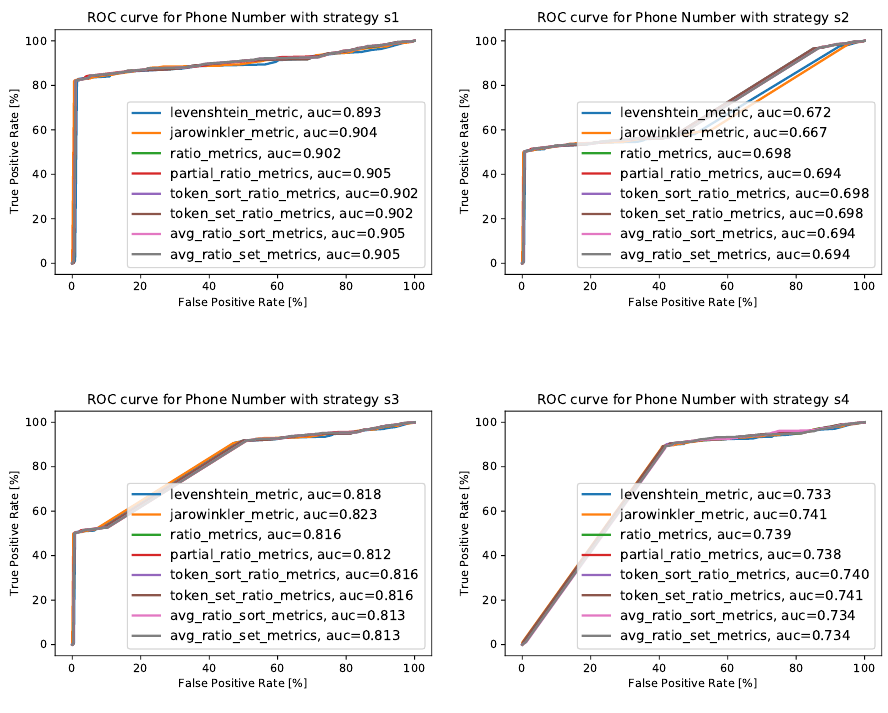
Figure A3. A receiver operating characteristics for all considered string similarity metrics for all four strategies for dealing with missing data for attribute Phone Number .